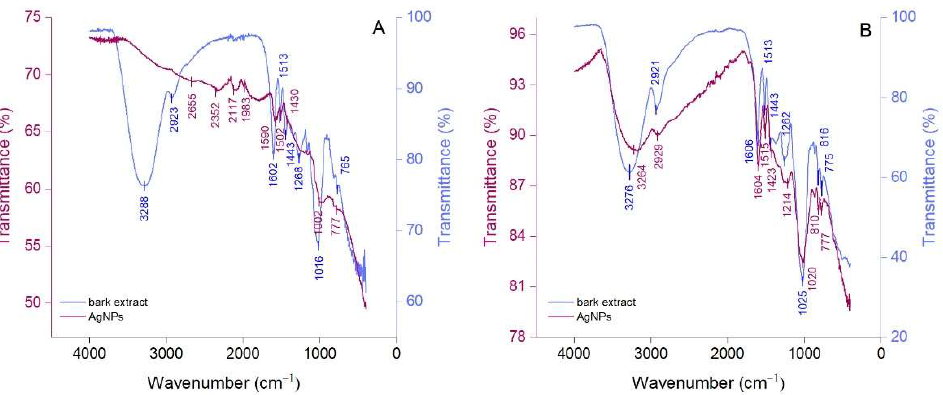
Figure 3. ATR-FTIR spectra of Picea abies ( A ) and Pinus nigra ( B ) bark extracts and their derived AgNPs.